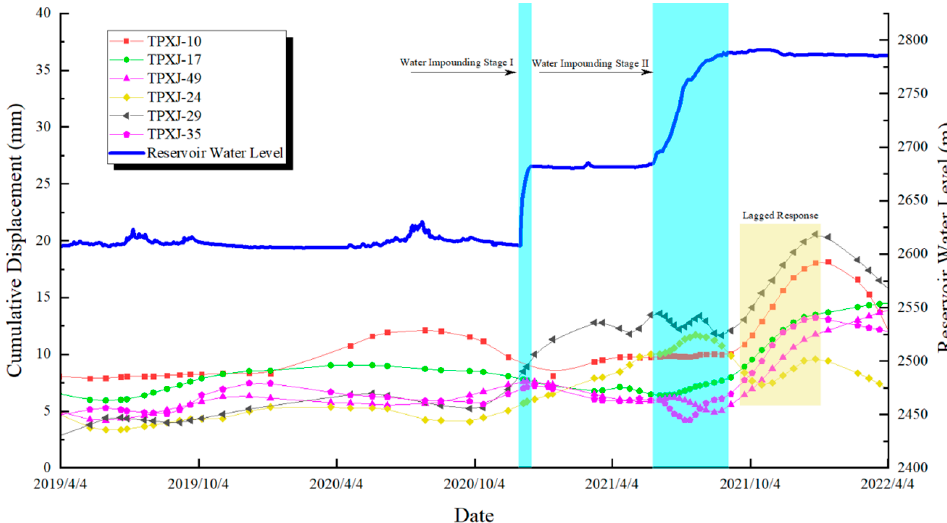
Figure 2. GNSS monitoring series data of high slope.